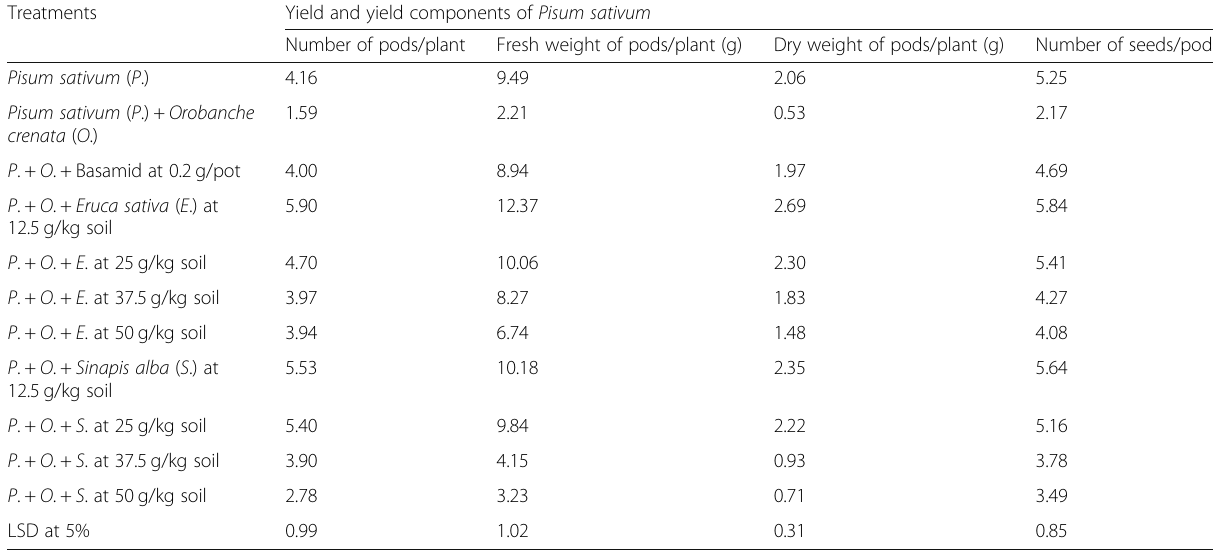
Table 5 Effect of different rates of both Eruca sativa and Sinapis alba seed powder on yield and yield attributes of Pisum sativum at harvest (combined analysis of two seasons) Treatments Yield and yield components of Pisum sativum Number of pods/plant Fresh weight of pods/plant (g) Dry weight of pods/plant (g) Pisum sativum ( P .)